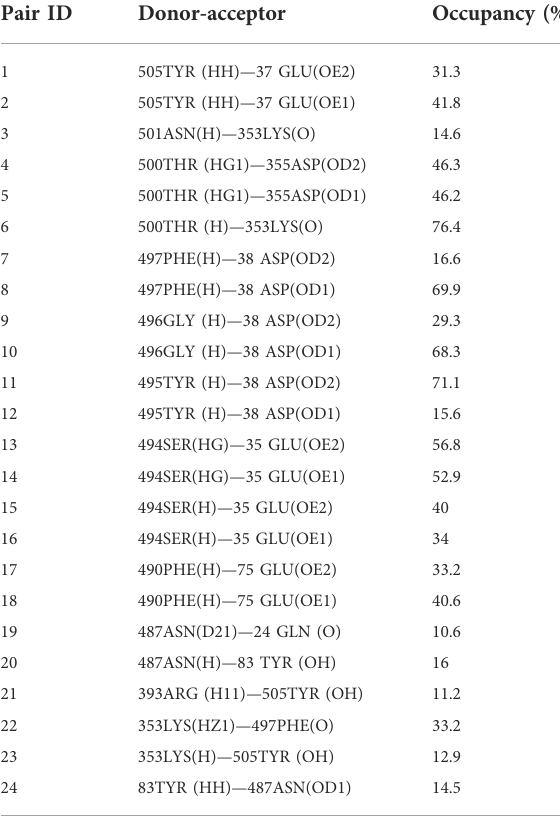
TABLE 2 The occupancy of H-bonds between the template peptide and ACE2 chain